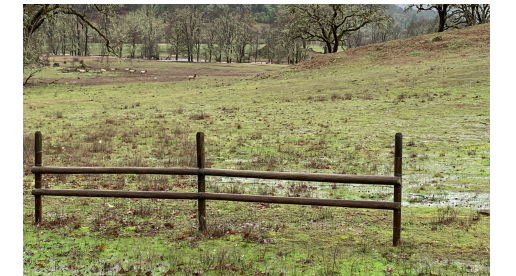
Fig. 5. Example of an “H-frame” elk crossing in Mendocino